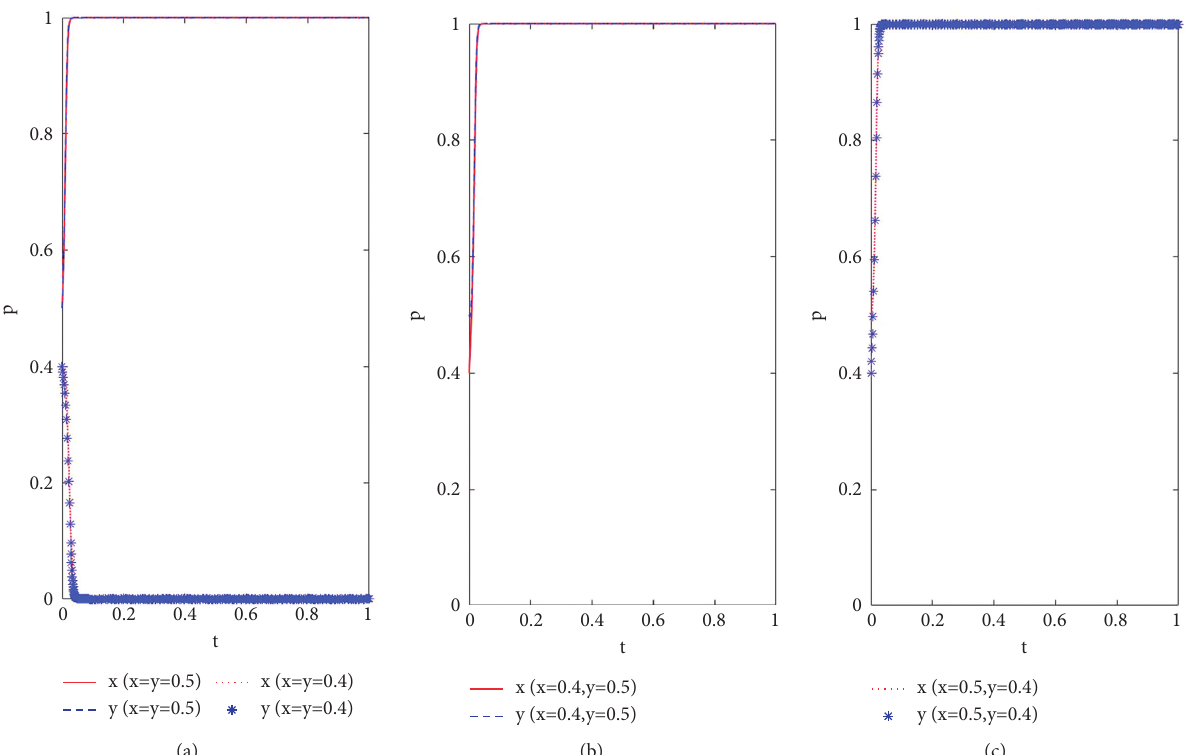
Figure 3: Evolution process of game system without government participation.